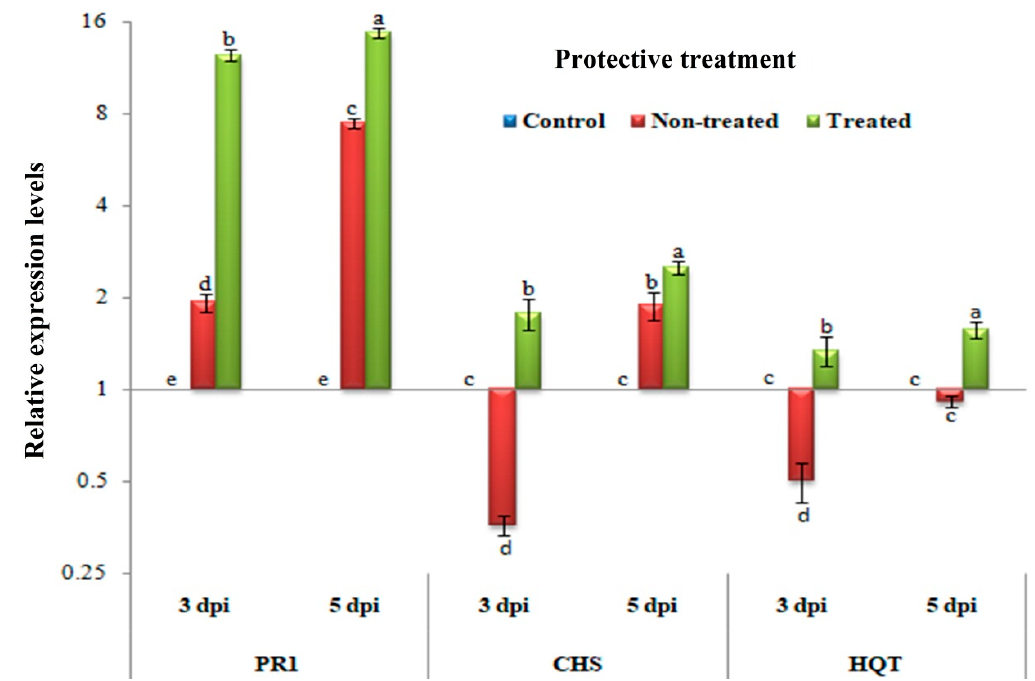
Figure 4. A histogram showing the relative expression levels of the PR-1, CHS, and HQT genes at 3 and 5 dpi of H. tuberculatum WPE treatments (200 μ g/mL) in the protective activity assay. Control = mock-treated plants; non-treated = plants inoculated with TMV only without any treatment; treated = plants treated with H. tuberculatum WPE, 24 h before inoculation of TMV for the protective assay and 24 h after inoculation of TMV for the inactivity assay. Columns represent the mean value from three biological replicates and the bars indicate SD. Significant differences between samples were determined by one-way ANOVA using CoStat software. Means were separated by the LSD test at p ≤ 0.05 and indicated by lowercase letters. Columns with the same letter do not differ significantly.